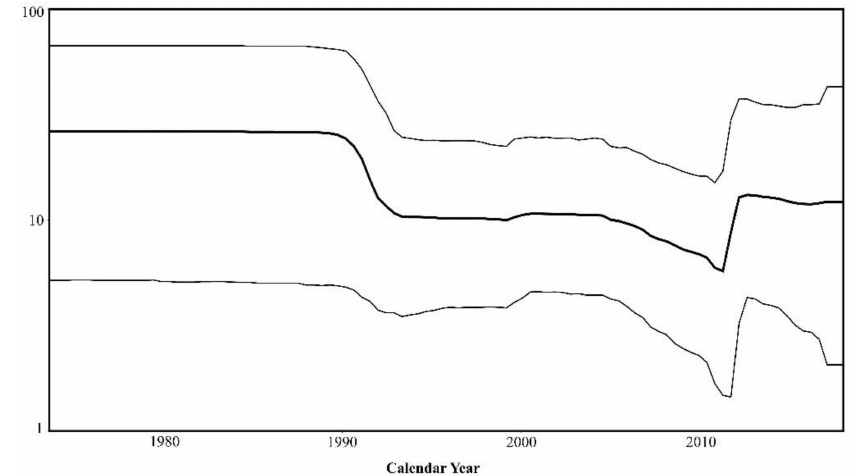
Figure 4. Bayesian skyline plot (BSP) reconstruct assuming an uncorrelated relaxed lognormal (UCLN) molecular clock under a GTR + G + I nucleotide substation model, with default tree priors. Fluctuations in e ff ective population size (y-axis) through time (Calendar years, x-axis) are